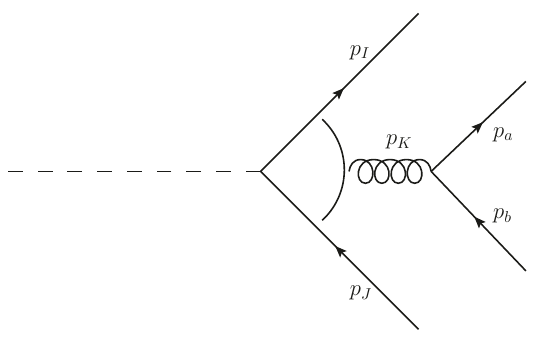
Figure 4 . A shower history where a gluon splitting follows a gluon